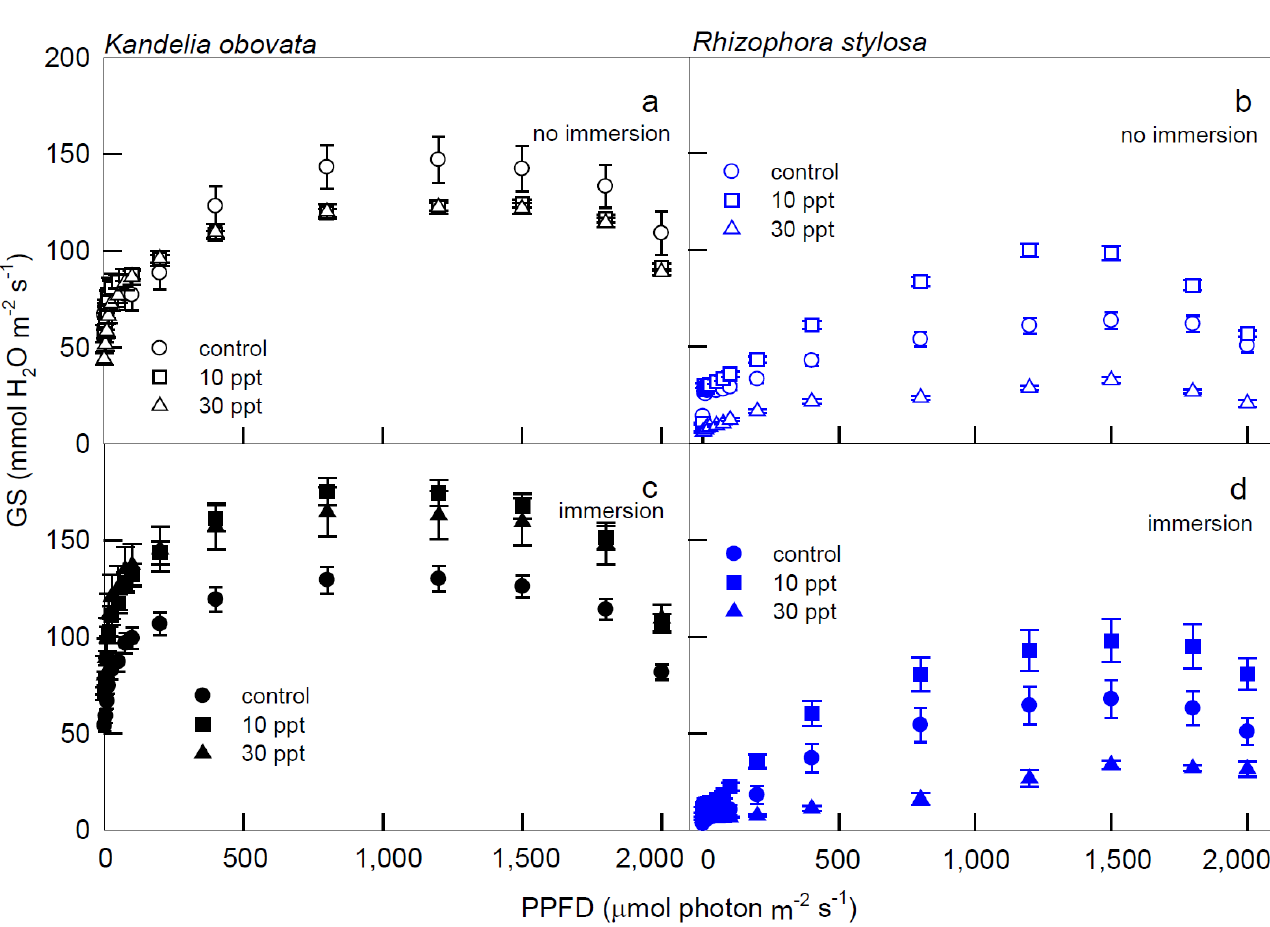
Figure 2. The light − response curves of stomatal conductance (Gs) in K. obovata ( a , c ) and R. stylosa ( b , d ) seedlings cultivated under 0, 10, and 30 ppt of salinity without immersion ( a , b ) and with immersion ( c , d ) conditions. Measurements were recorded at 25 °C with different PPFD at 0, 5, 10, 15, 25, 50, 75, 100, 200, 400, 800, 1200, 1500, 1800, and 2000 μmol photon·m −2 ·s −1 . Each data point represents as mean ±SE of 3 leaves from five replicates ( n = 15) for each salinity treatment. The relationships between the Pn and Gs of the K. obovata and R. stylosa plants in different salinity treatments under 1200 – 2000 µmol PPFD m −2 ·s −1 illuminations are shown